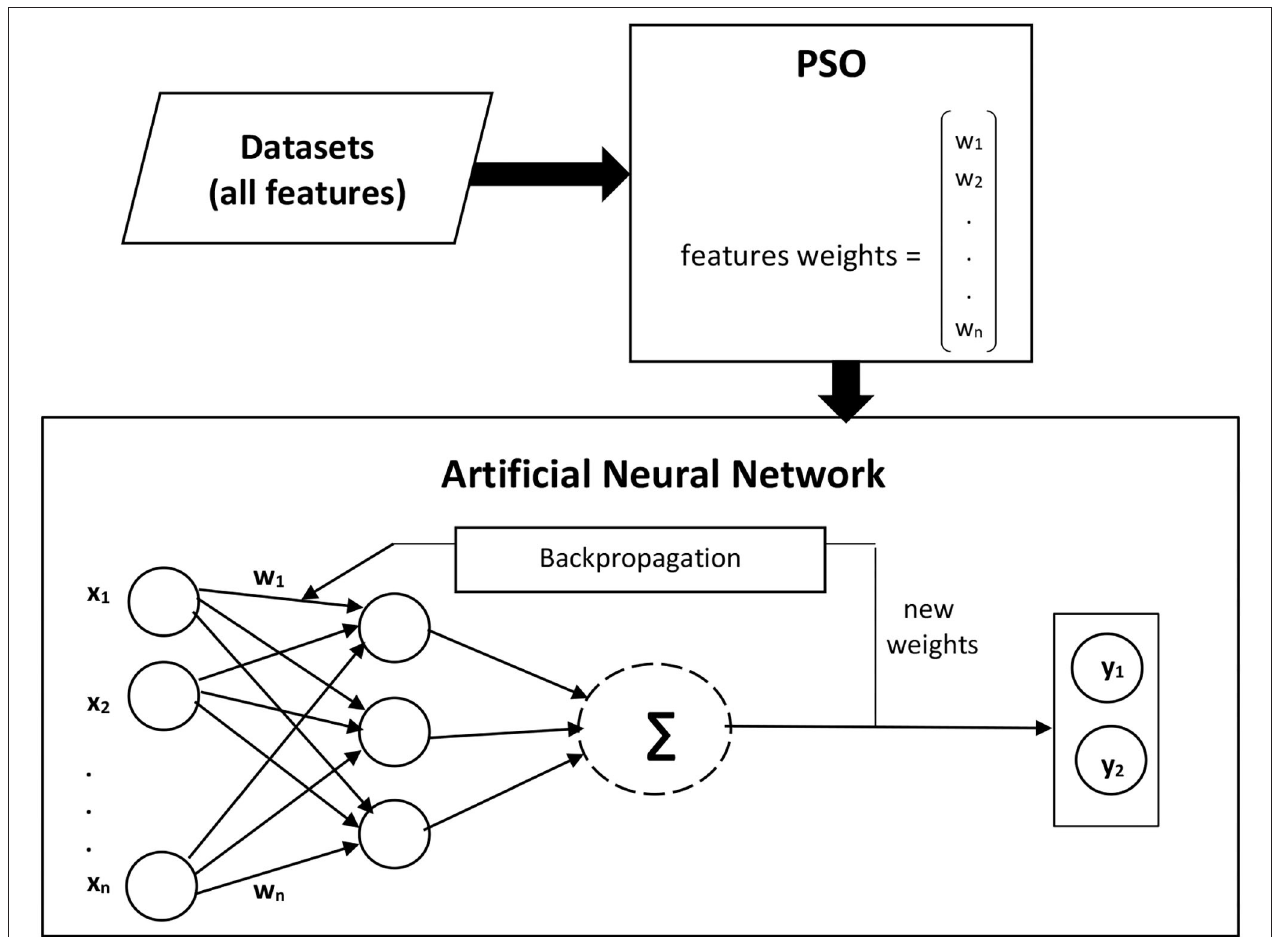
FIGURE 2 | Proposed model